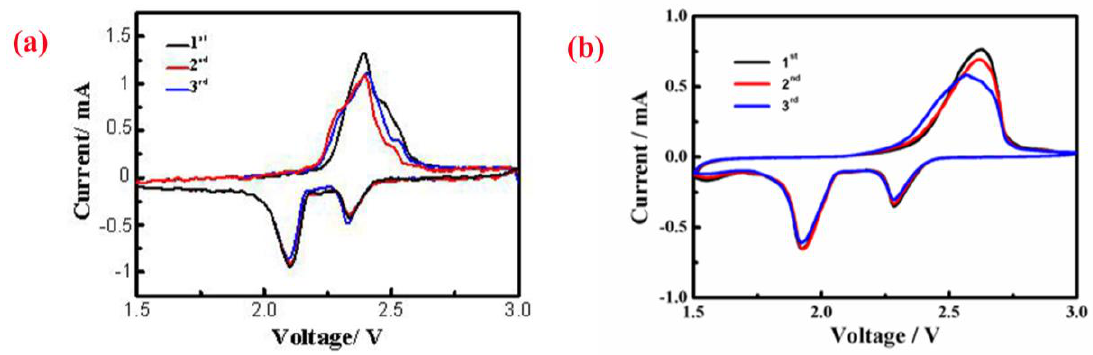
Figure 12. Cyclic voltammetry (CV) curves of the ( a ) S/CeO 2 /RGO and ( b ) S/RGO cathodes at a scan rate of 0.1 mV s −1 .